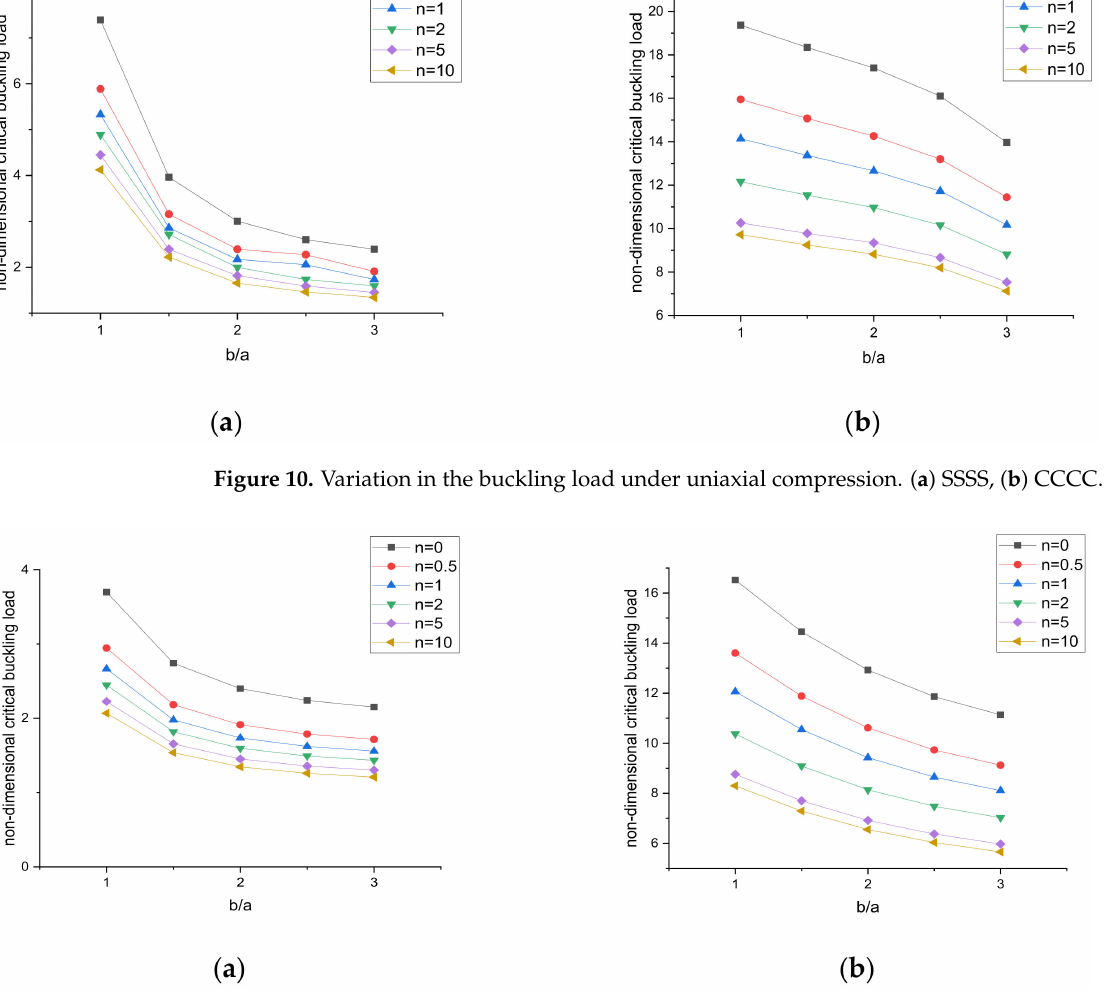
Figure 11. Variation in the buckling load under biaxial compression. ( a ) SSSS, ( b )